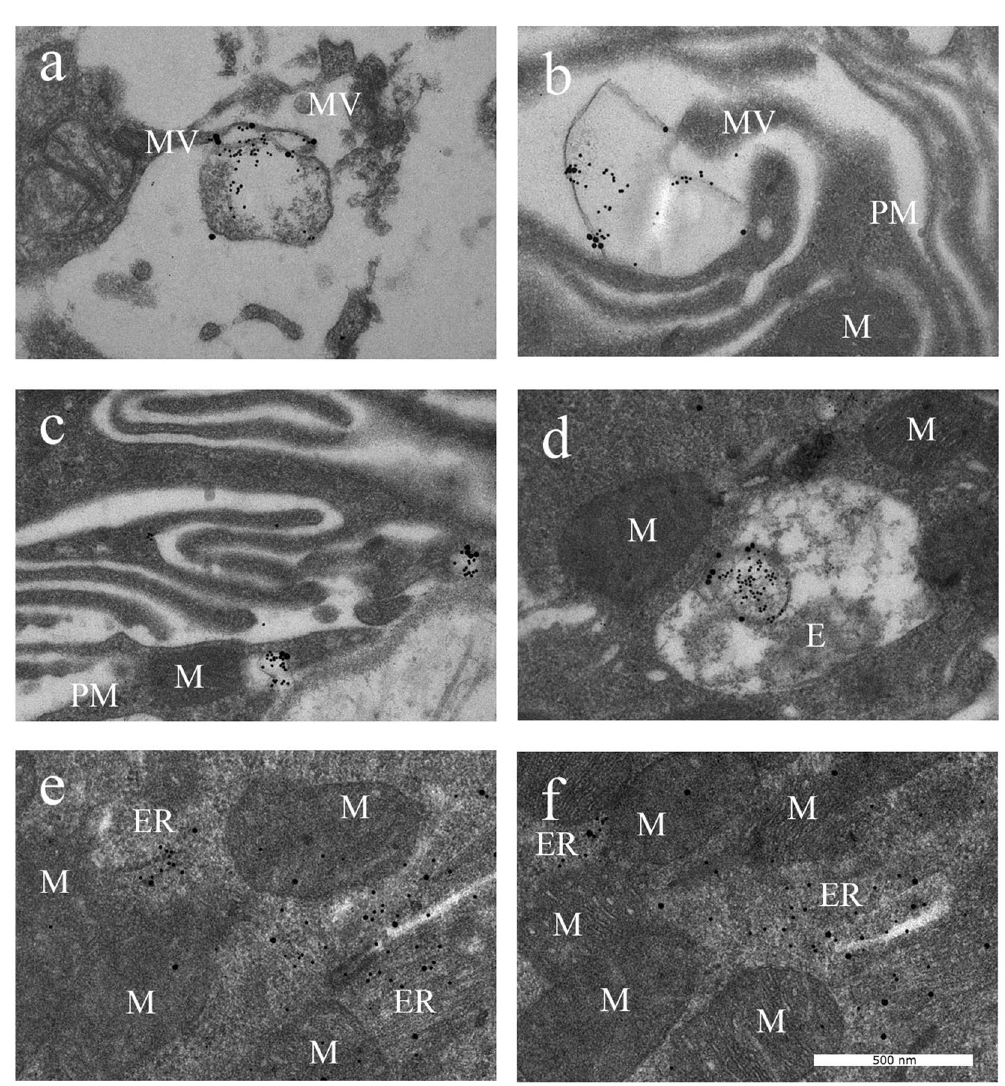
Figure 7. STBEV uptake and effect of free HbF visualised by transmission electron microscopy. The normal STBEVs, co-treated with HbF, appear to bind the plasma membrane ( a ), which is ruffled ( b,c ) as was also seen in cells treated with PE STBEVs (see Fig. 6b). The STBEVs were internalised into endosomes ( d ) and transported to intracellular compartments ( e,f ). The mir-517c is localised predominantly into the ER than in the mitochondria ( e,f ), also seen in cells treated with PE STBEVs (see Fig. 6e). Abbreviations; E endosome, ER endoplasmic reticulum, MV microvilli, M mitochondria, N nucleus, PM plasma membrane. PLAP labelled with 20 nm and mir-517c labelled with 5 nm colloidal